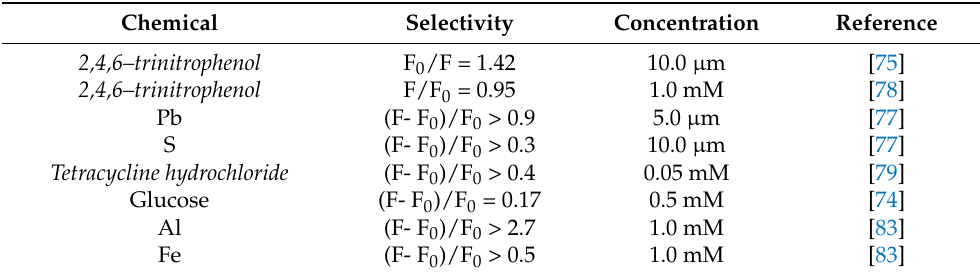
Table 5. Chemical Sensing Capabilities of MoS 2 QDs.